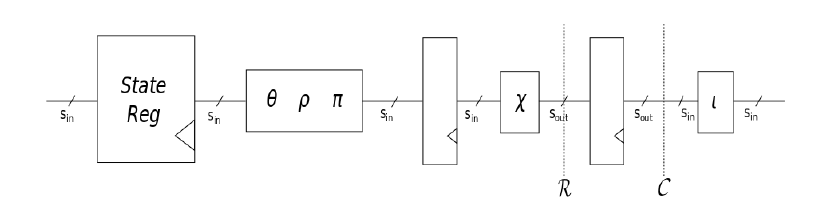
Figure 3: One round structure of the naive fix, with refreshing ( R ) and compression ( C ) before ι .